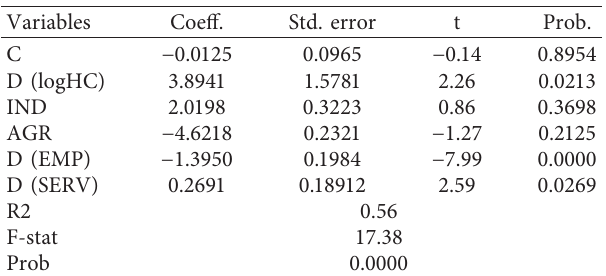
Table 3: Dynamic equation (dependent variable � highest 20% income group).